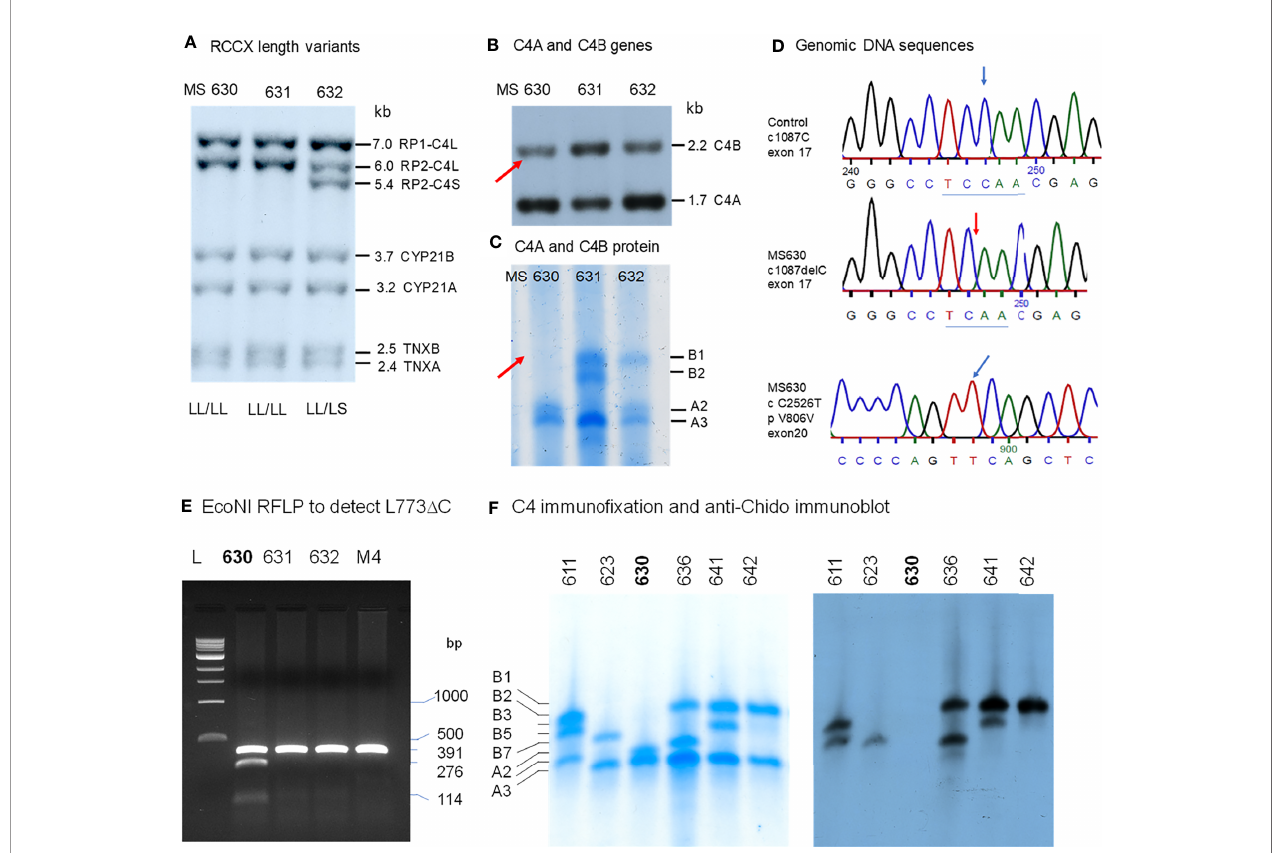
FIGURE 4 | Molecular genetic analyses of a young European American subject with a mutant C4B gene (MS630). Experimental approaches were similar to those described in Figure 3 . (A) Taq I RFLP of three consecutive subjects to show RCCX structures. (B) Psh AI/ Pvu II to show the relative dosage of C4A and C4B . Notice that one C4B gene and three C4A genes were present in MS630 and MS632. (C) Immuno fi xation of C4A and C4B protein allotypes using EDTA-plasma from the same subjects shown in panels (A, B) . No C4B was detectable in MS630. (D) DNA sequences at exon 17 from a control subject ( upper panel ) and MS630 ( middle panel ) showing a single C-nucleotide deletion in codon 755 (Q755) of C4B in MS630. The lower panel shows a C ! T polymorphism for codon 806 from exon 20 that did not change the amino acid sequence Val-806. (E) Eco NI RFLP to detect the C-nucleotide deletion for MS630 and control M4. A 391-bp DNA fragment spanning intron 16 (I-16.5) and the 5 ’ region of exon 18 (E18-r) was ampli fi ed by PCR, digested with Eco NI and resolved with agarose gel electrophoresis. Panel (F) shows results of immuno fi xation (left) and immunoblot (right) experiments for fi ve subjects. C4 protein allotypes in MS630 did not react with anti-Chido monoclonal. The GenBank accession number for the DNA fragment containing sequence with C-deletion in MS630 is